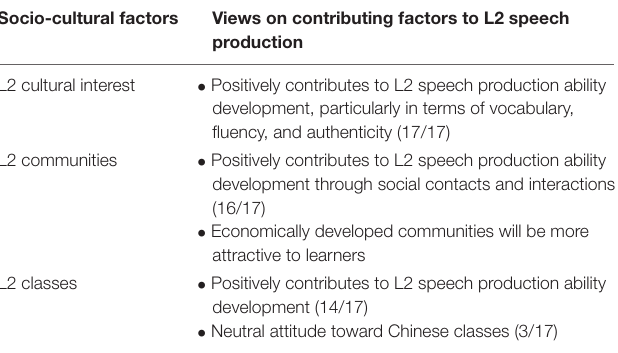
TABLE 4 | Socio-cultural dimensions of multilinguals’ L2 Chinese speech production. Socio-cultural factors Views on contributing factors to L2 speech